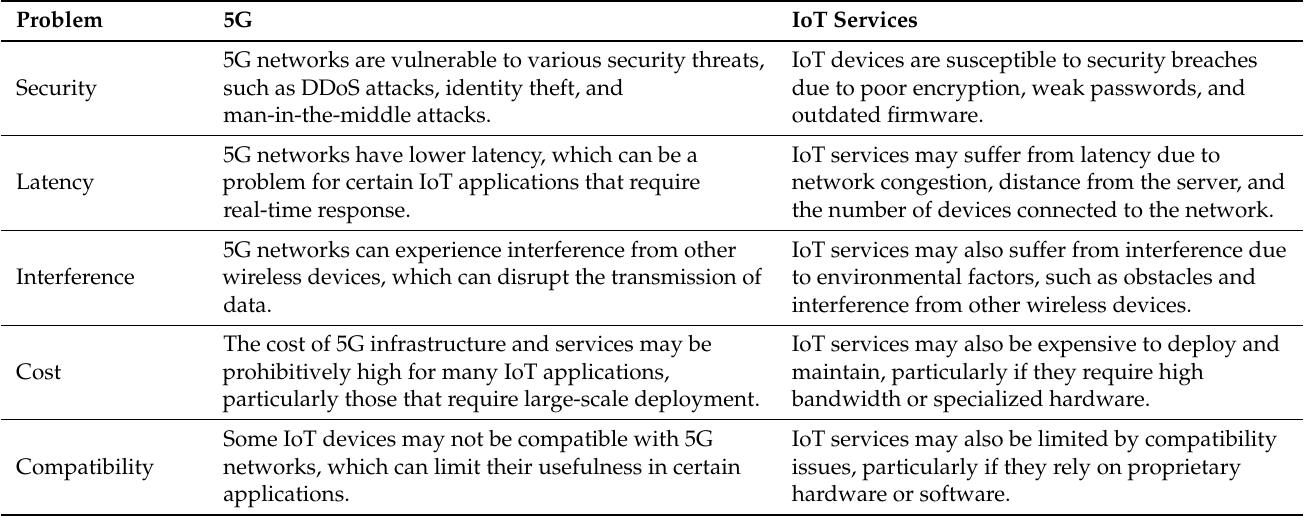
Table 2. Comparison of problems presented by 5G and IoT